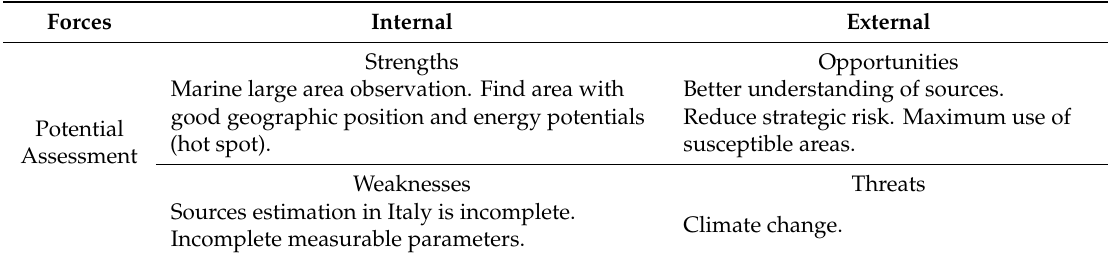
Table 2. SWOT analysis of potential assessment